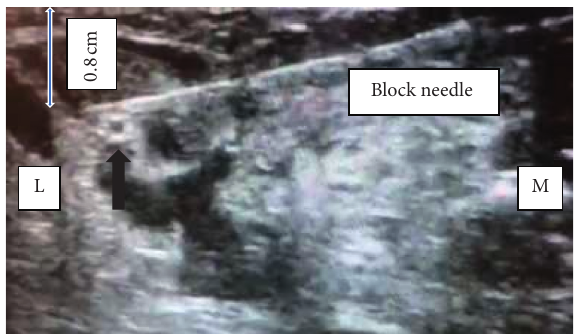
Figure 3: ICBN with block needle positioned immediately before local anaesthetic infiltration. Black arrow indicates the hyperechoic ICBN (M: medial; L: